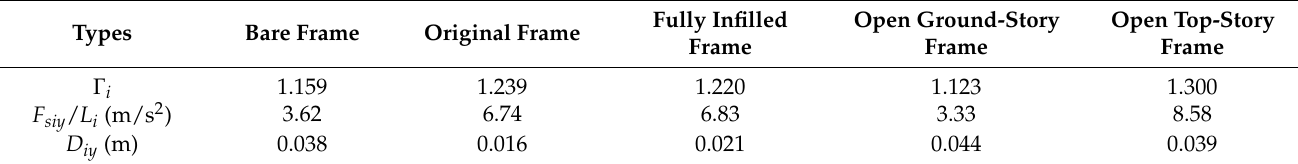
Figure 16. Actual cyclic pushover curves versus idealized nonlinear SDOF system curves of build- ing RES: ( a ) bare frame; ( b ) original frame; ( c ) fully infilled frame; ( d ) open ground-story frame; ( e ) open top-story frame. Table 6. Properties of the first modal inelastic SDOF systems of RES. Table 6. Properties of the first modal inelastic SDOF systems of RES.